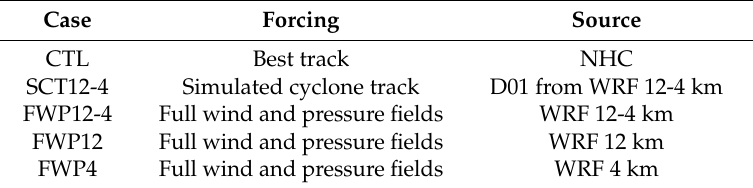
Table 3. Description of meteorological forcing for each coupled